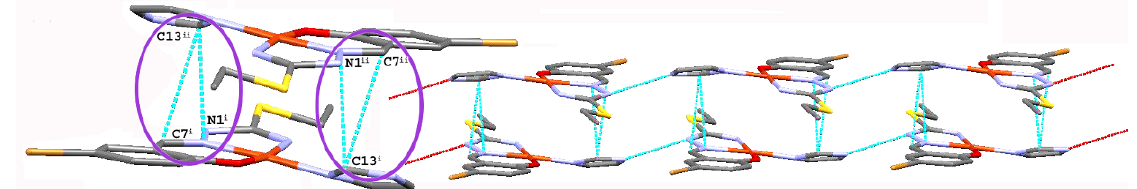
Figure 2. Crystal packing diagram (sym. code i: x,y,z ii: -x,-y,-z). Table 2. Selected bond lengths (Å) and angles ( o ) in the experimental and at the B3LYP/6-311++G calculation. type Exp. Calc. Type Exp. Calc.